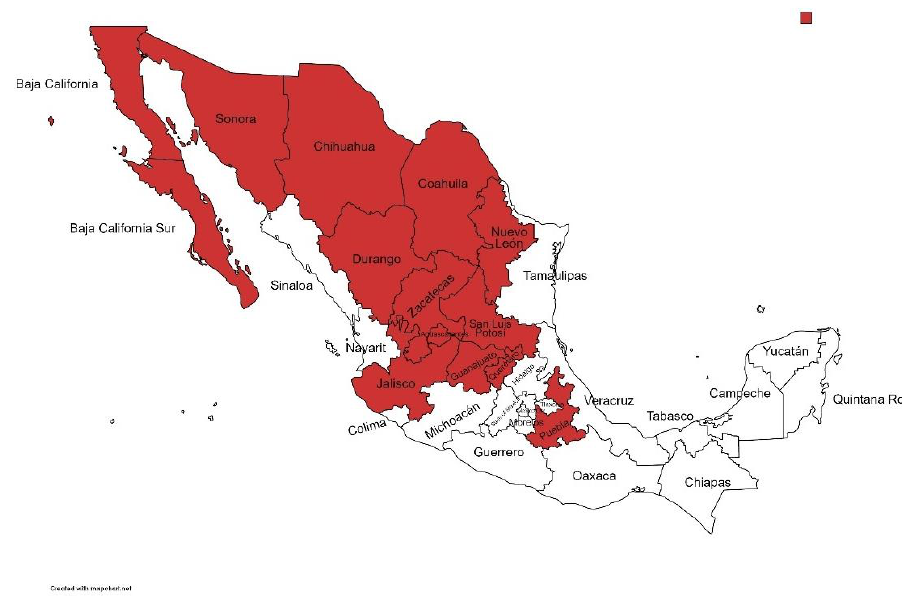
Figure 1. Main grapevine producing states in Mexico indicated in red color.